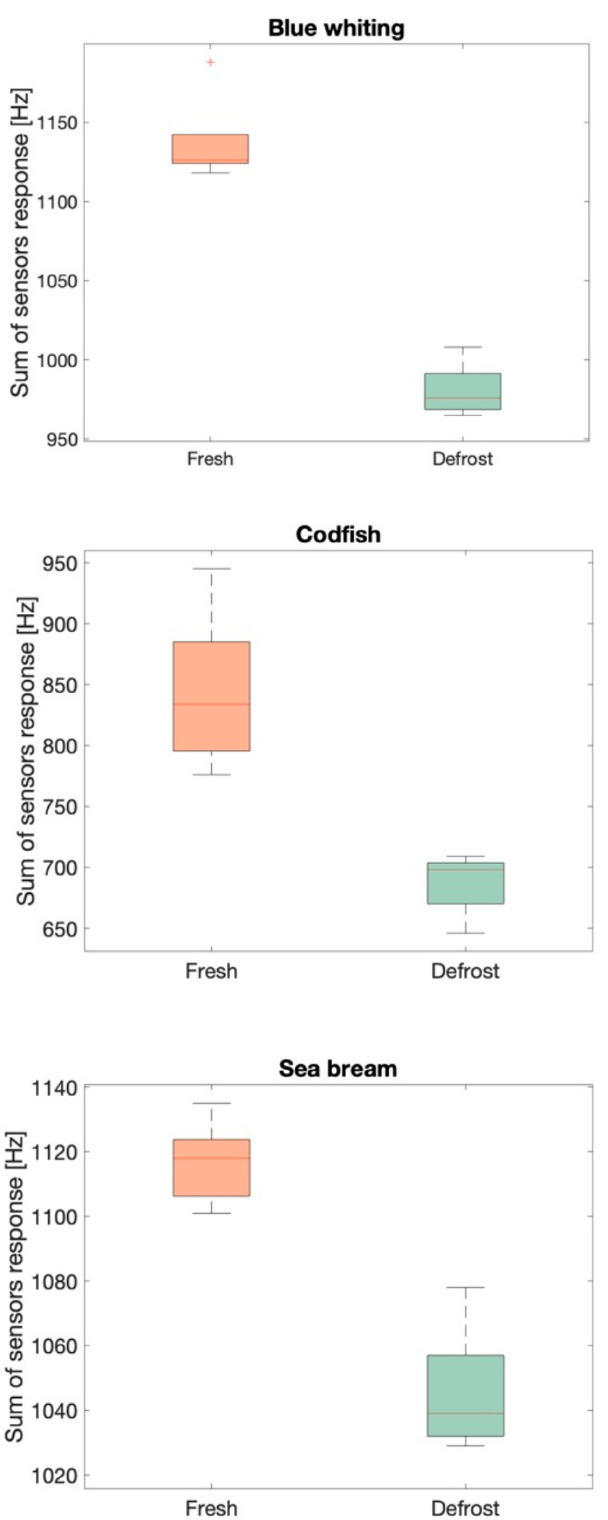
Figure 7. Boxplots of the olfactive intensity for each fish species (from up to down) blue whiting, codfish, sea bream, divided into two populations: fresh and defrosted. The boxes (green for defrost and orange for fresh) represents the 25–75% quartiles of each population. The median is shown with a horizontal line inside the box. The minimal and maximal values are shown with short horizontal lines